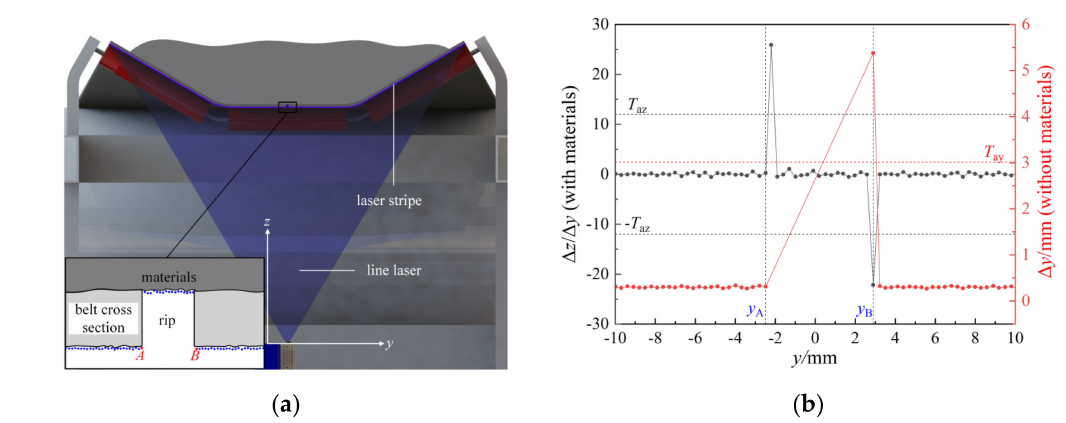
Figure 3. Point distribution near the rip. ( a ) The cross-section view with the line laser plane as the cutting plane, the bottom illustration is the zoom view of the middle rectangle box near the rip. ( b ) The data analysis chart for finding the suspected points (point A and B shown in ( a )), the black dots correspond to the values of ∆ z / ∆ y of the points when the belt upper surface covered with materials, while the red dots correspond to the values of ∆ y of the points when the belt upper surface covered with no